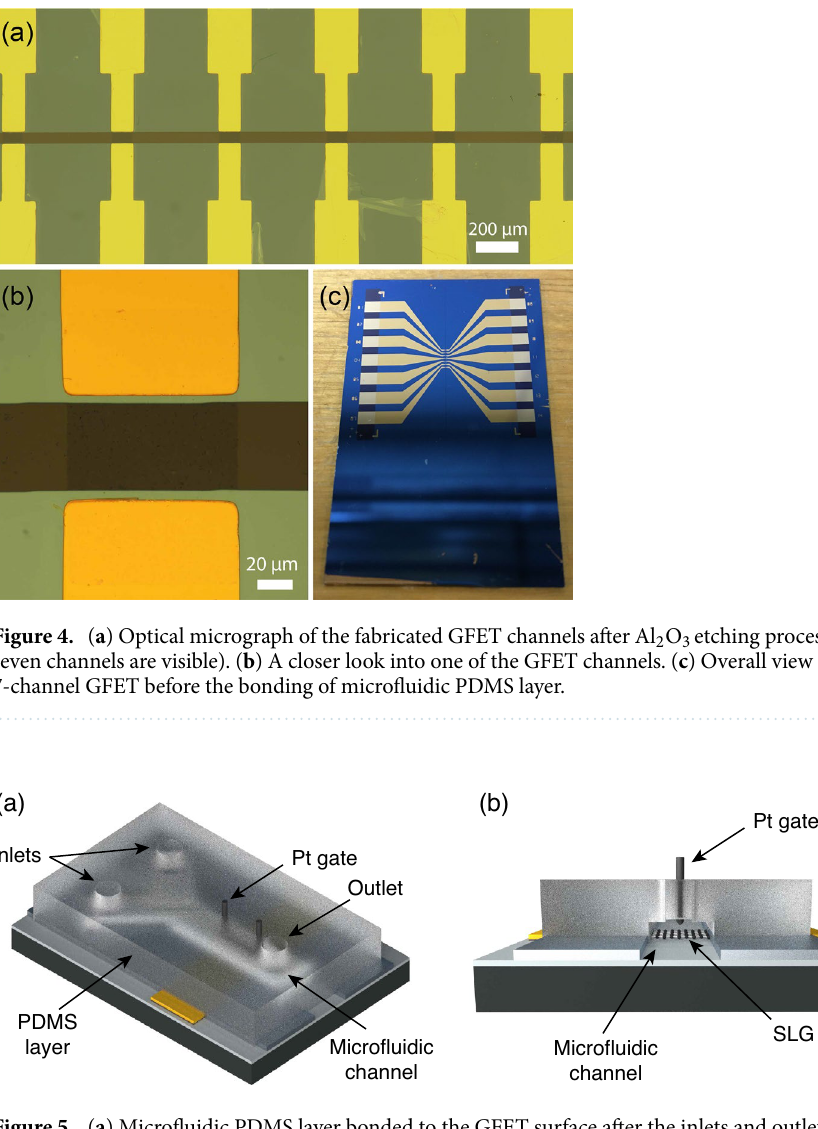
Figure 5. ( a ) Microfluidic PDMS layer bonded to the GFET surface after the inlets and outlet are defined, and the Pt gate electrode is placed on top. ( b ) Cross-sectional view of the MC receiver after PDMS layer